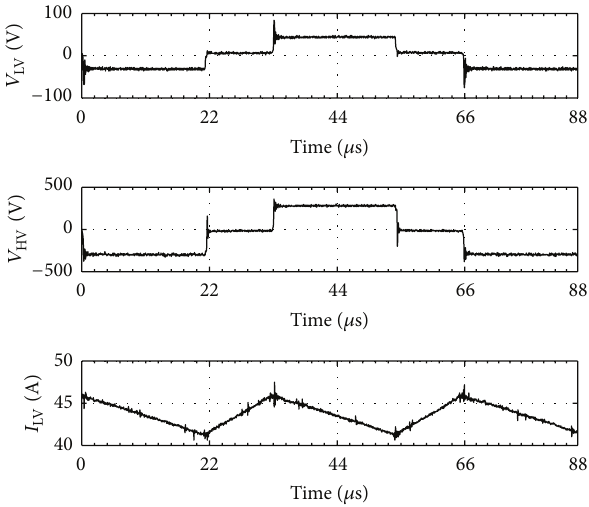
Figure 17: Boost mode test of a single cell: input: 𝑉 ) = 43.5 A, and 𝛿 = 0.677; output: 𝑉 avg (𝐼 LV